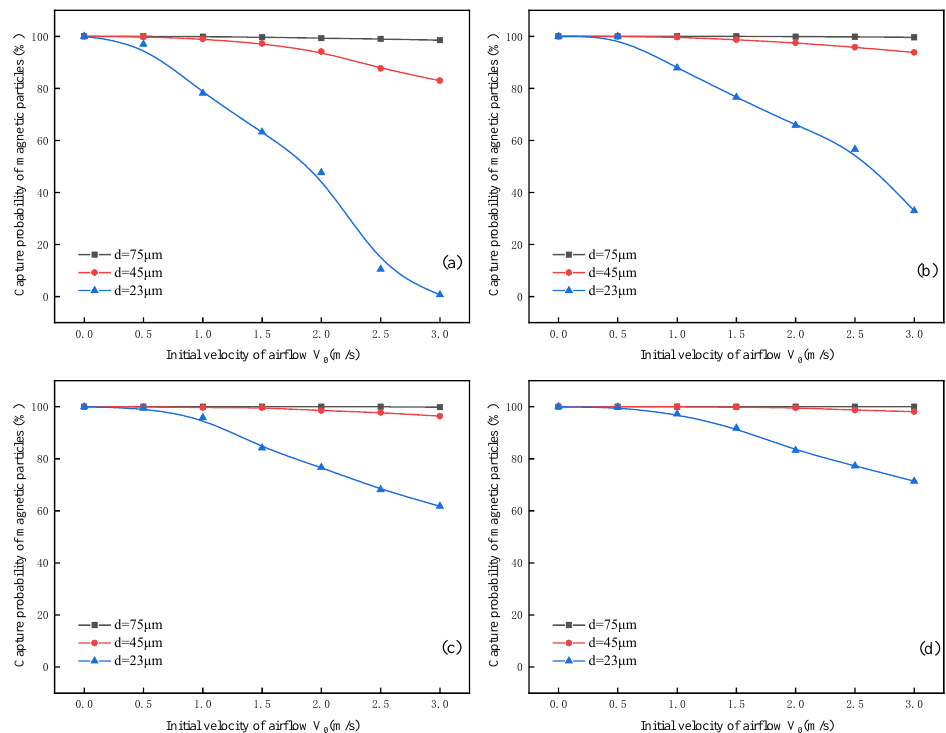
Figure 12. Variation of magnetic particle capture probability with air velocity under different rem- anence conditions: ( a ) 𝐵 𝑟 = 1.0 T, ( b ) 𝐵 𝑟 = 1.2 T, ( c ) 𝐵 𝑟 = 1.4 T, and ( d ) 𝐵 𝑟 = 16 T.